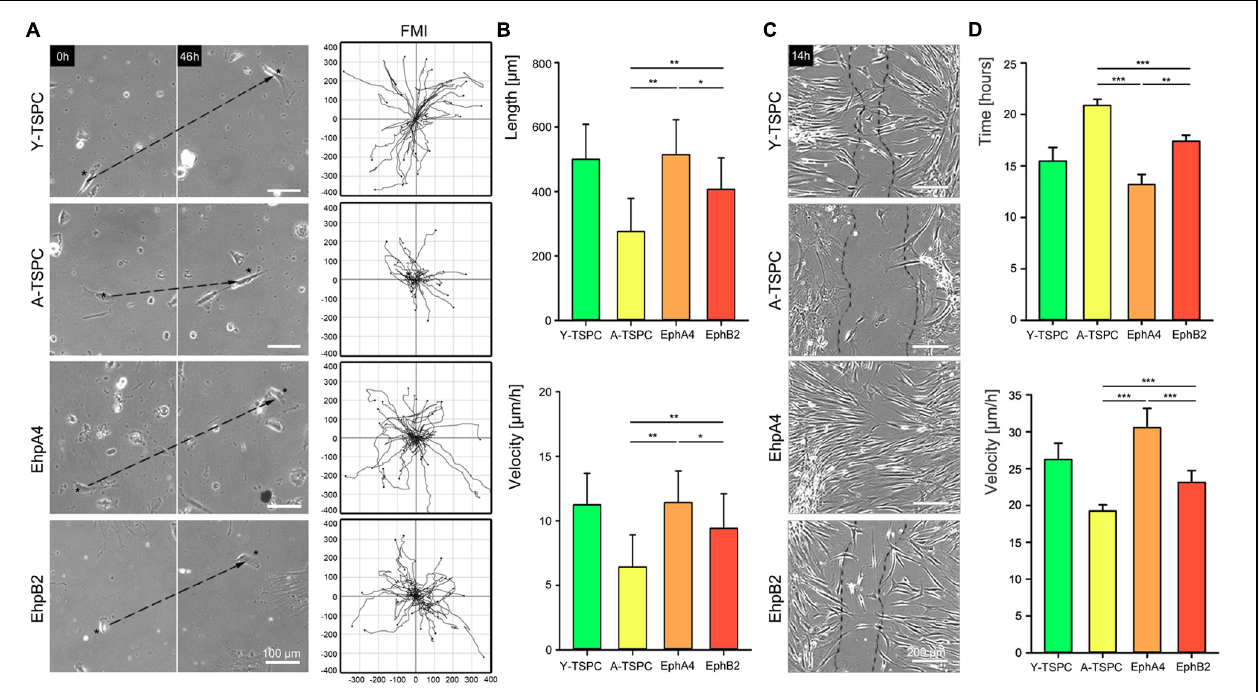
FIGURE 4 | Migration of EphA4-Fc and EphB2-Fc A-TSPC. (A) Representative images of random migration (dash lines show ecludian distance) and calculation of forward migration index (FMI). Bars = 100 μ m. (B) Quantification of random migration (distance and velocity) ( n = 9, total of 150 tracks per donor type).